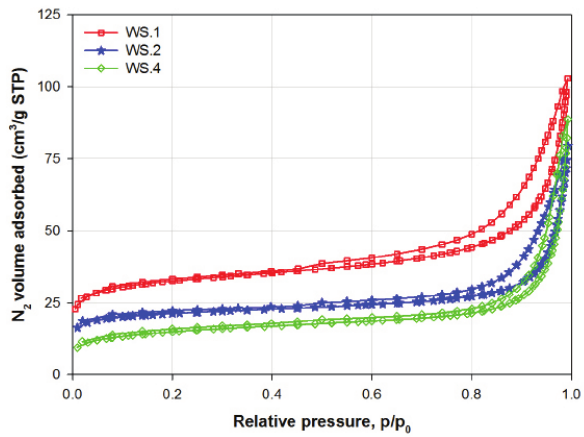
adsorption/desorption isotherms of synthesized MgO- Figure 7: N 2 ZrO oxide materials not subjected to further heat treatment. 2